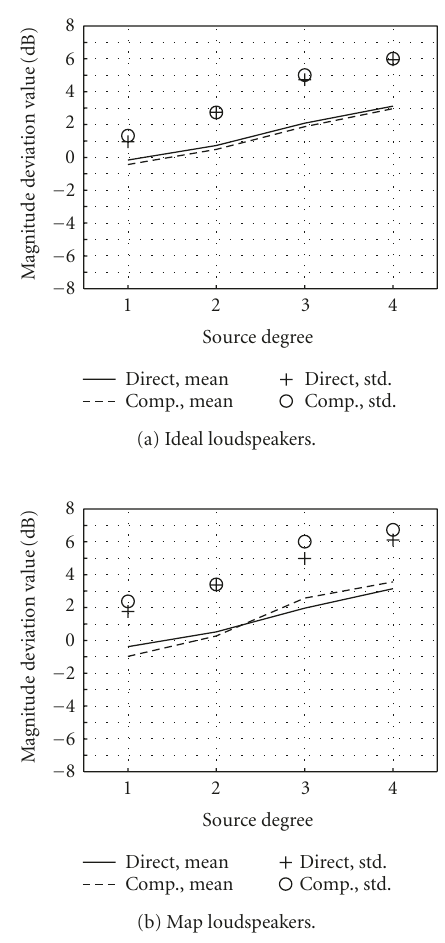
evalu- Figure 19: Mean value and standard deviation of MAG Ψ m ated below the aliasing frequency for all microphone and source positions. Synthesis of “combined” directivity (cf. (23)). Compar- ison between recomposition from elementary directivity (recomp) and direct synthesis (direct). All filters are calculated using multi- channel equalization